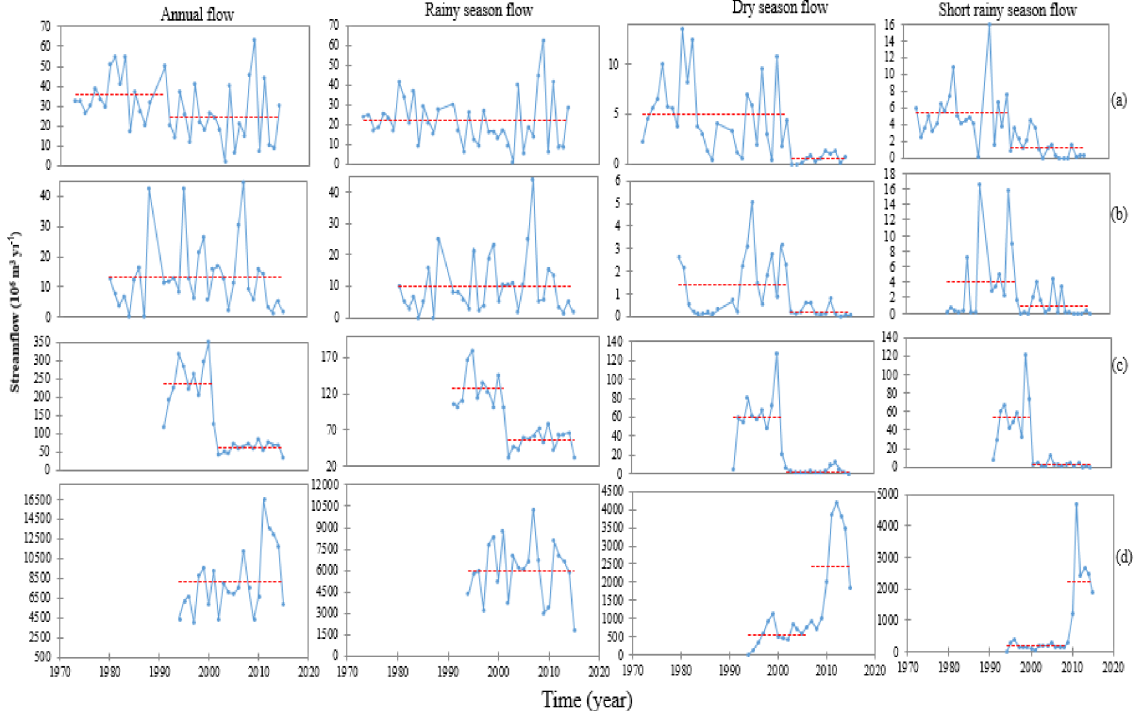
Figure 6. Annual and seasonal streamflow abrupt changes as determined by Pettitt test at (a) Siluh, (b) Illala, (c) Geba 1 and (d)